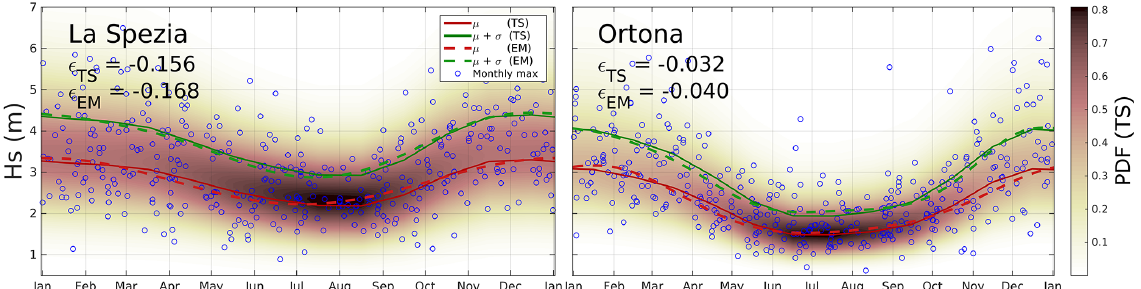
Figure 10. Seasonal cycle estimated by TS methodology and by the EM for the series of significant wave height of La Spezia and Ortona. The red continuous (dashed) line represents the location parameter µ estimated by TS (EM). The green continuous (dashed) line represents the sum between the location parameter µ and the shape parameter σ estimated by TS (EM). The dots represent the monthly maxima. The shape parameters ε TS and ε EA estimated by the two methodologies have been also reported for the two series.